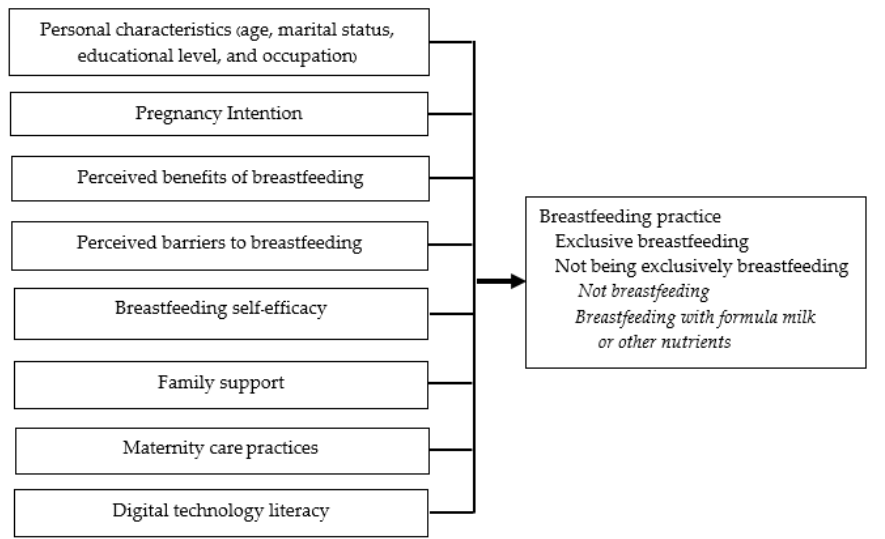
Figure 1. Research conceptual framework .